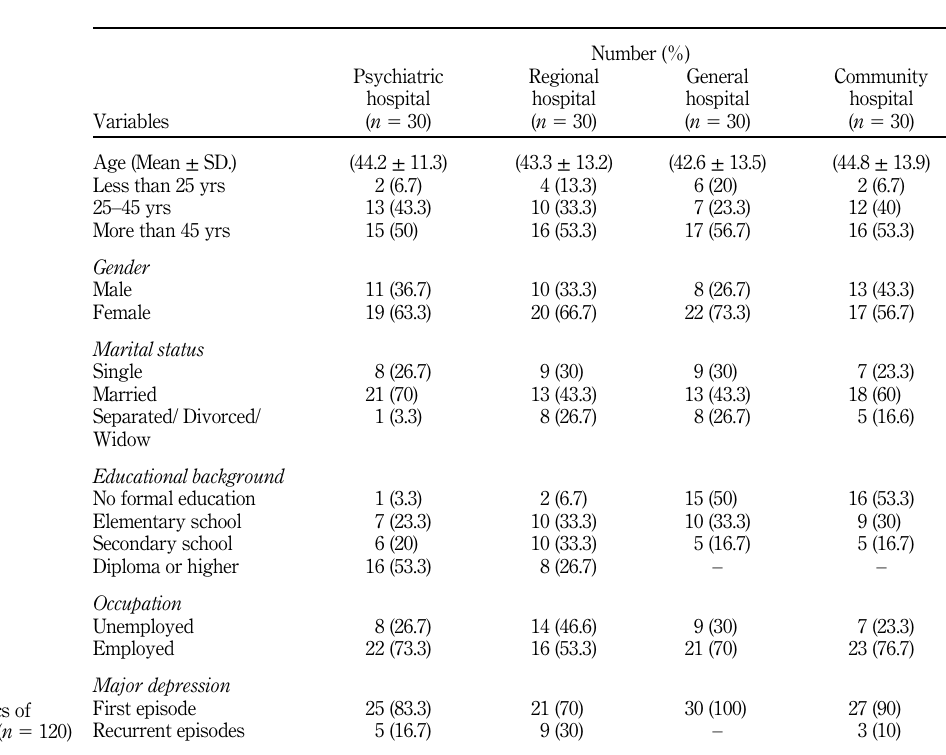
characteristics of respondents ( n 5